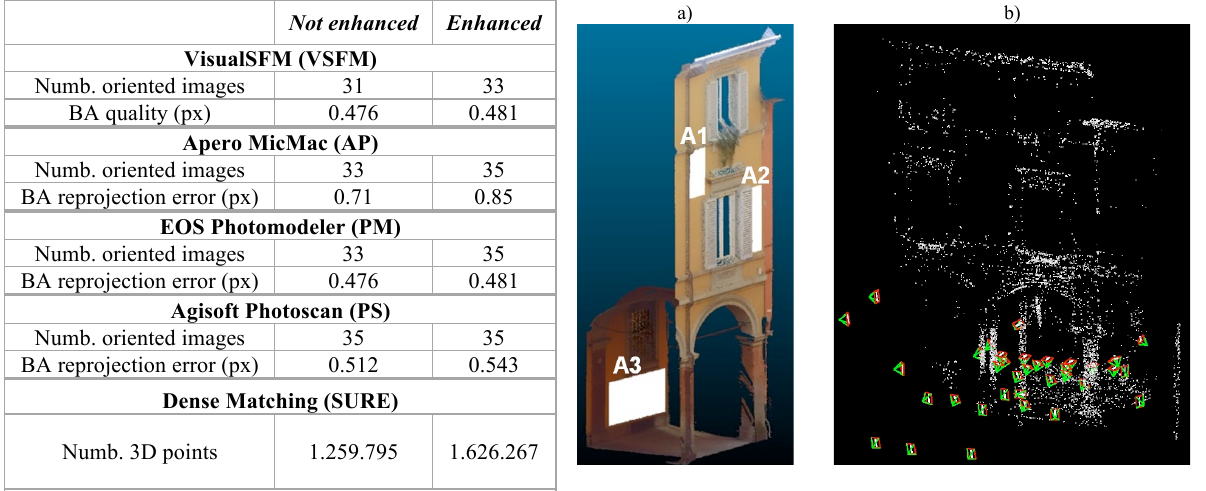
Table 1: Bundle adjustment (BA) results and dense matching Figure 4: The TLS survey with the 3 textureless regions of interest (a) and improvement for the enhancement procedure. the camera network of the Portico dataset (b). NO DENOISE Adobe